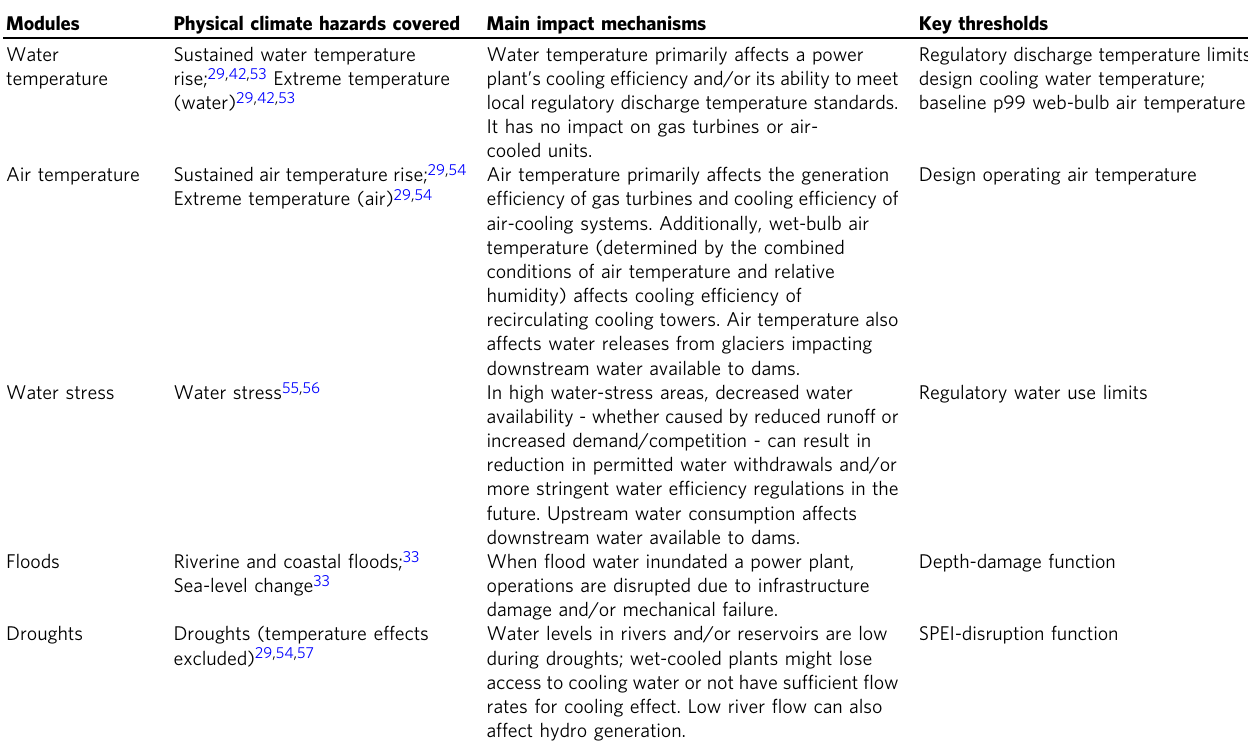
Table 1 Physical climate risk assessment modules in the power